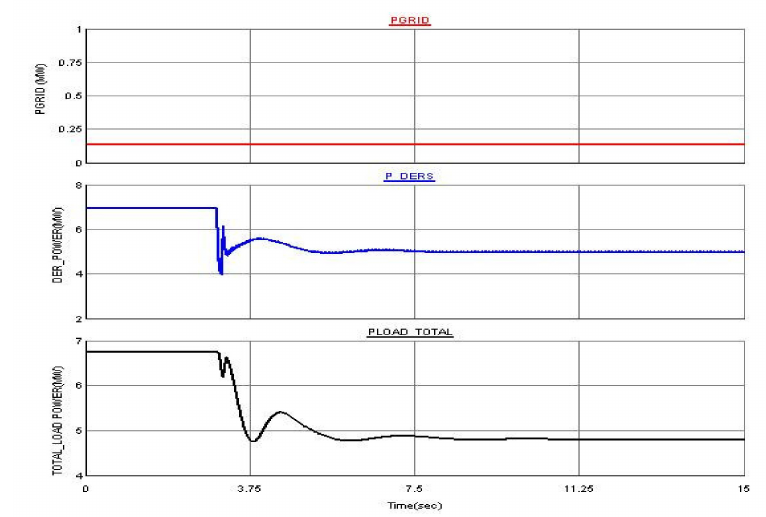
Figure 19. Grid, DERs and Load active